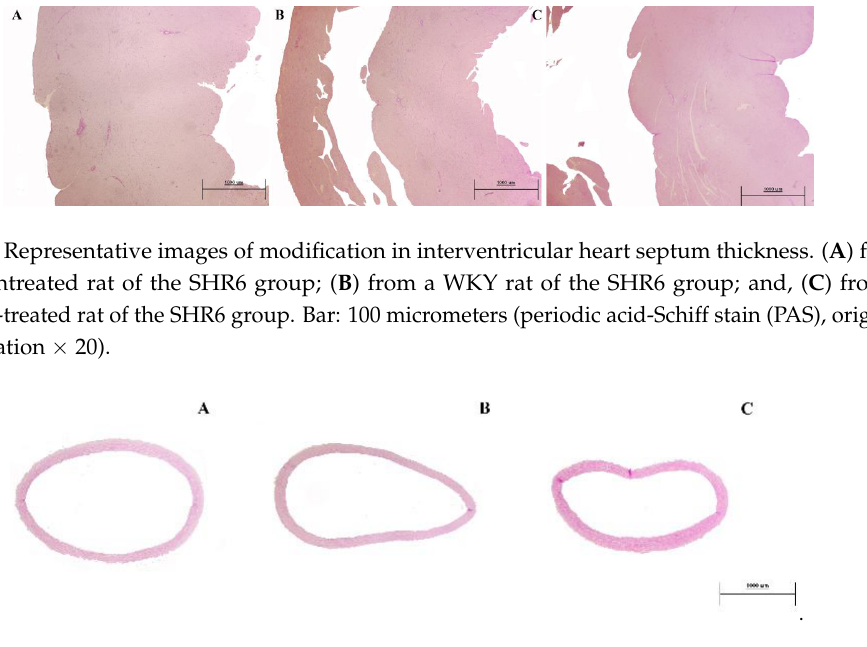
Figure 5. Representative microphotograph of thoracic aorta wall thickness modification in SHR12 rats. (A) flavonoid-treated group (COE group); (B) WKY control rat; and, (C) SHR control rat. Bar: 100 micrometers (PAS, original magnification × 0.2).